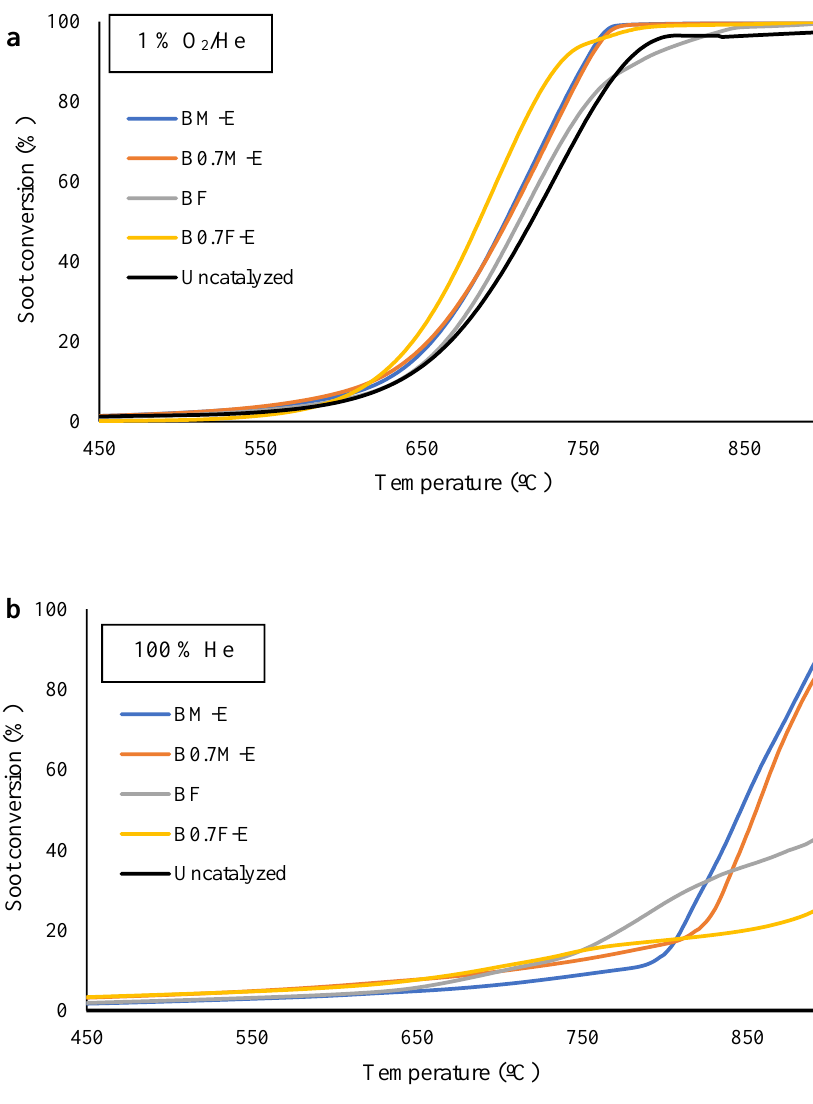
Figure 9. Soot conversion profiles (soot-TPR) for the catalysts in 1% O 2 in He ( a ) and in 100% He ( b ). In 1% O 2 /He, the B0.7F-E sample presents the lowest T 50% value, so it seems that the spinel structure of B0.7F-E catalysts presents a higher ability to adsorb and dissociate O 2 from the gas phase than a perovskite structure [80].